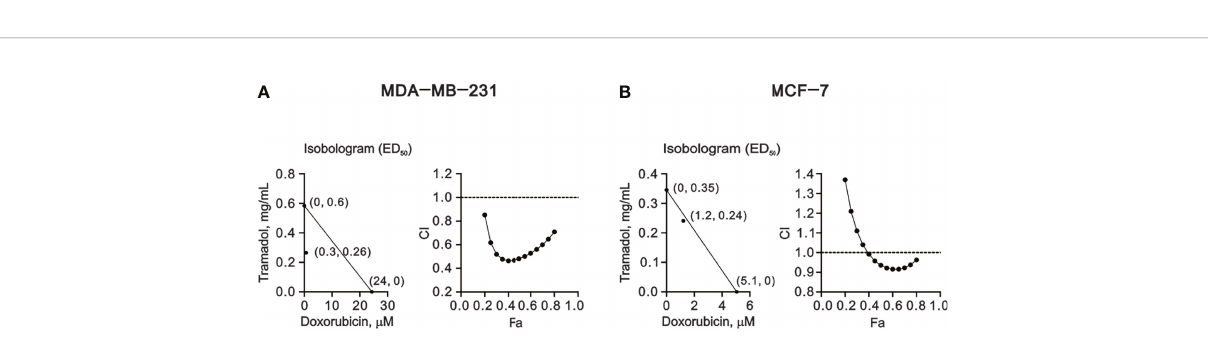
FIGURE 5 | The effects of tramadol on protein expression in human breast cancer cells. (A, B) MDA-MB-231 and MCF-7 cells were treated with tramadol (0, 0.05, 0.1, 0.5, 1 and 1.5 mg/mL) for 4 h. b -actin (lower panel) served as the loading control.